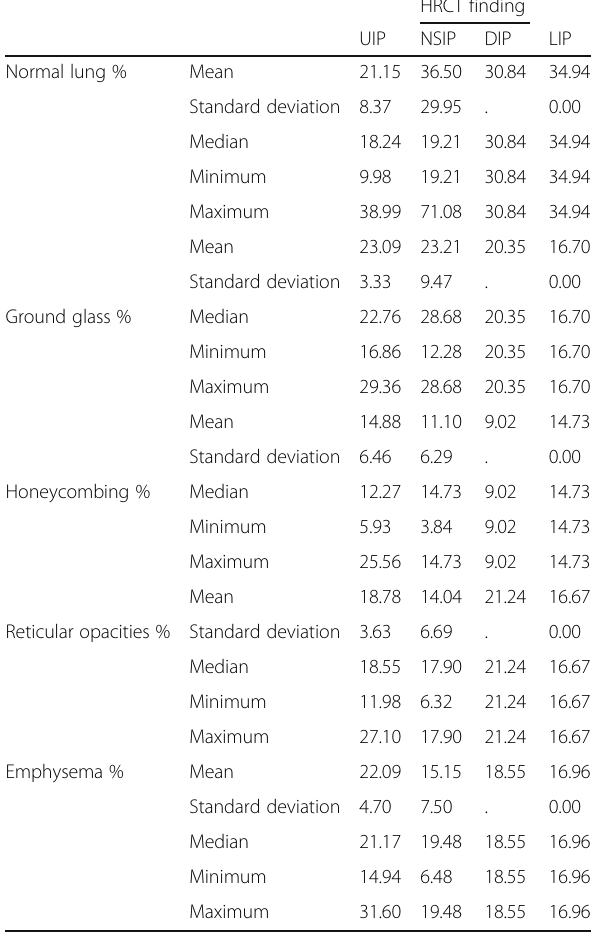
Table 4 Distribution of honeycombing, ground glass, reticular, emphysema, and normal lung derived from all CT slices by QCT according to IIP